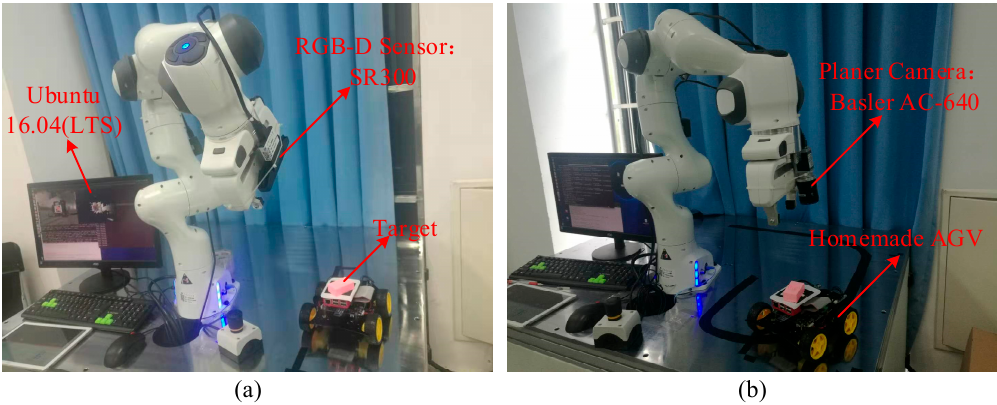
Figure 9. Experimental system composition. ( a ) Experimental system with RGB-D camera; ( b ) experimental system with planar camera.